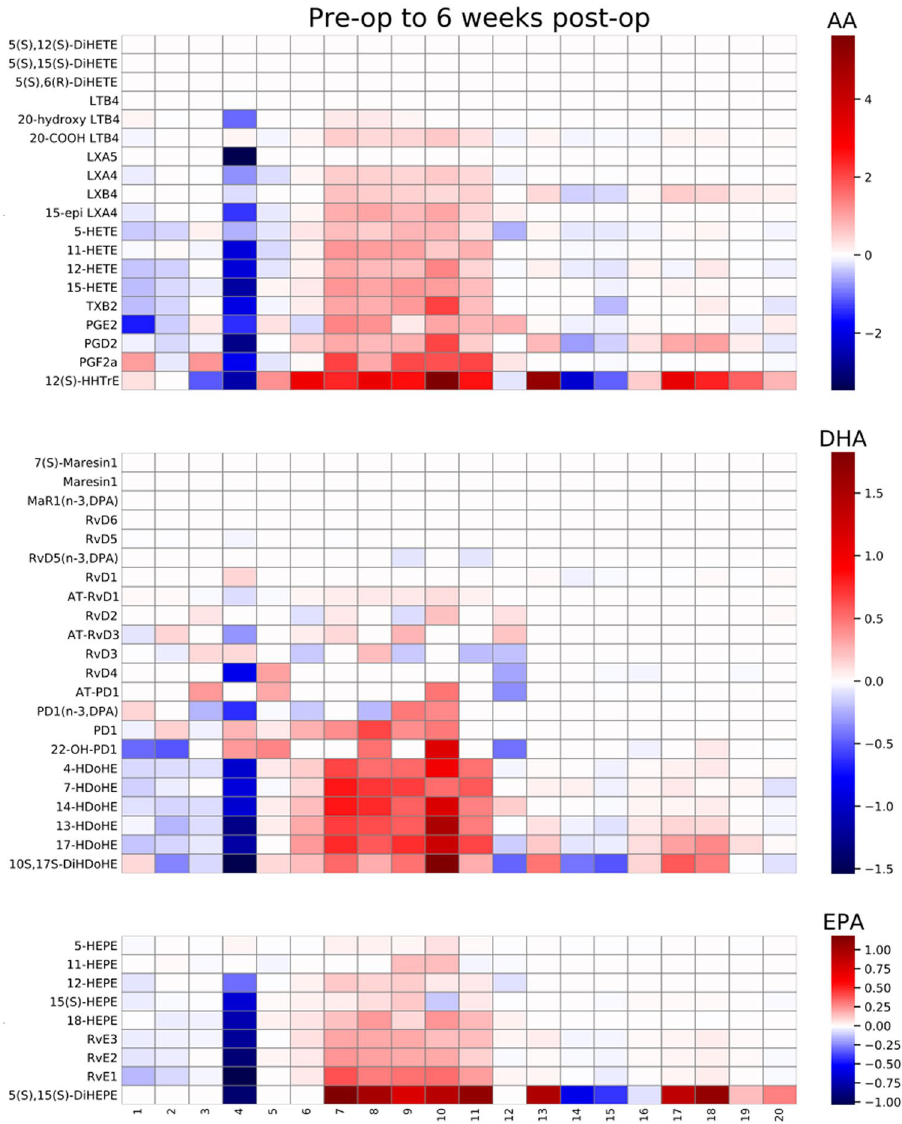
Figure 3. Centrifuged CSF cell pellet heatmaps for AA, DHA, and EPA derived metabolite pathway changes from pre-op to 6 weeks post-op (N = 20). Patients are listed as numbers on the x-axis for each heatmap. Heatmap scale numbers represent natural log ratios of analyte concentrations from pre-op to 6 weeks